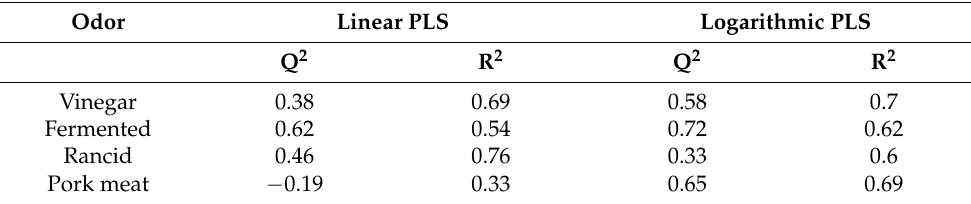
Table 3. Results of quality parameters of the predicted model for the chorizo odors, obtained by linear and logarithmic Partial Least